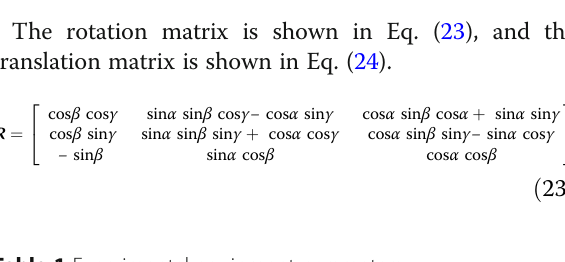
Table 1 Experimental equipment parameters Equipment Mold no.